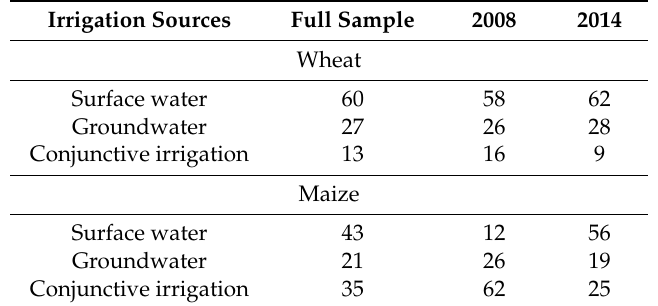
Table 1. Share of sample plots by sources of irrigation water in Zhangye, Heihe River Basin